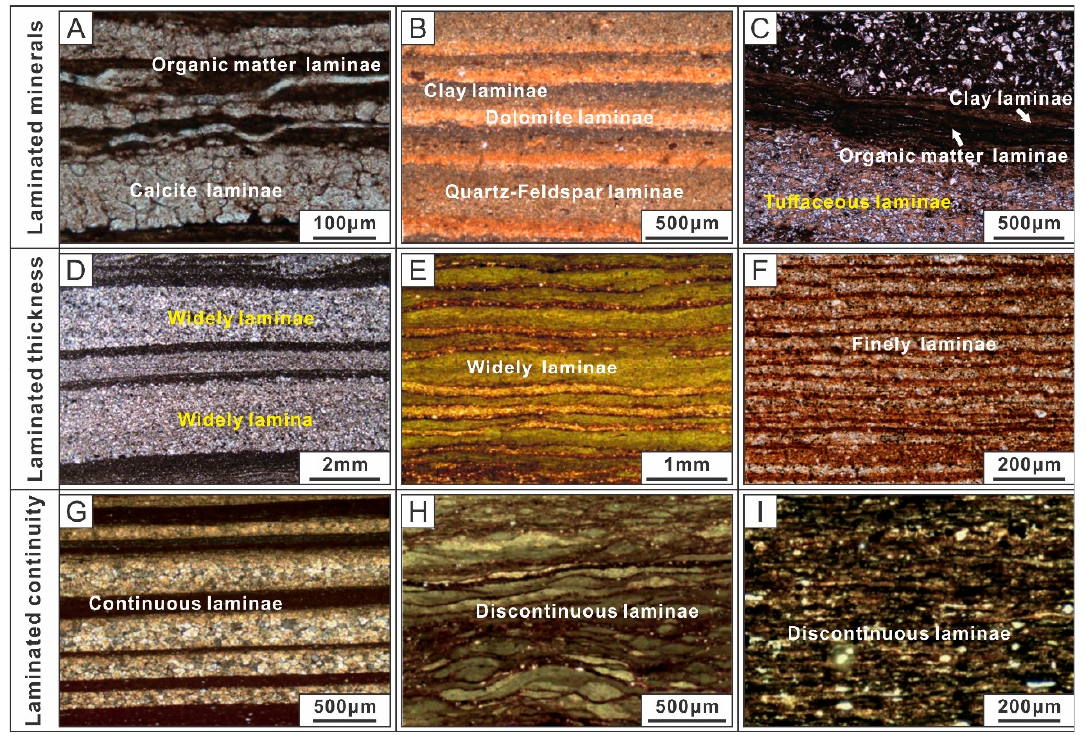
Figure 1. Terminology for the description of laminae, mainly including mineral composition, thickness, and continuity, in different classification schemes. ( A – C ) The types of laminae described by the mineral composition of laminae. ( D – F ) The types of laminae described by the thickness of laminae. ( G – I ) The types of laminae described by the continuity of laminae. Modified after [11,15,40–43].